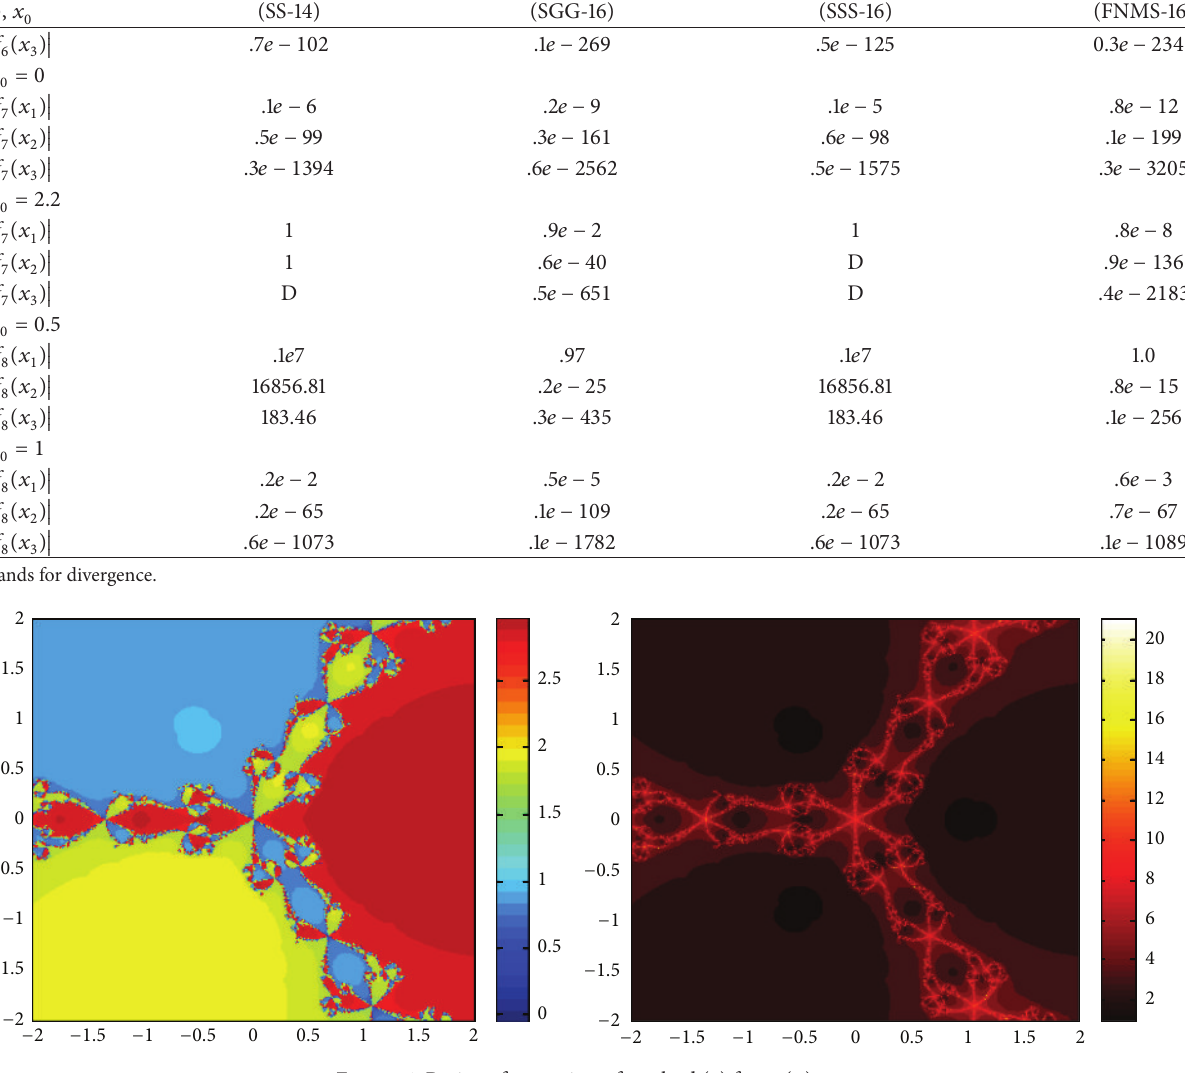
Figure 1: Basins of attraction of method (7) for 𝑝 3 (𝑥) .